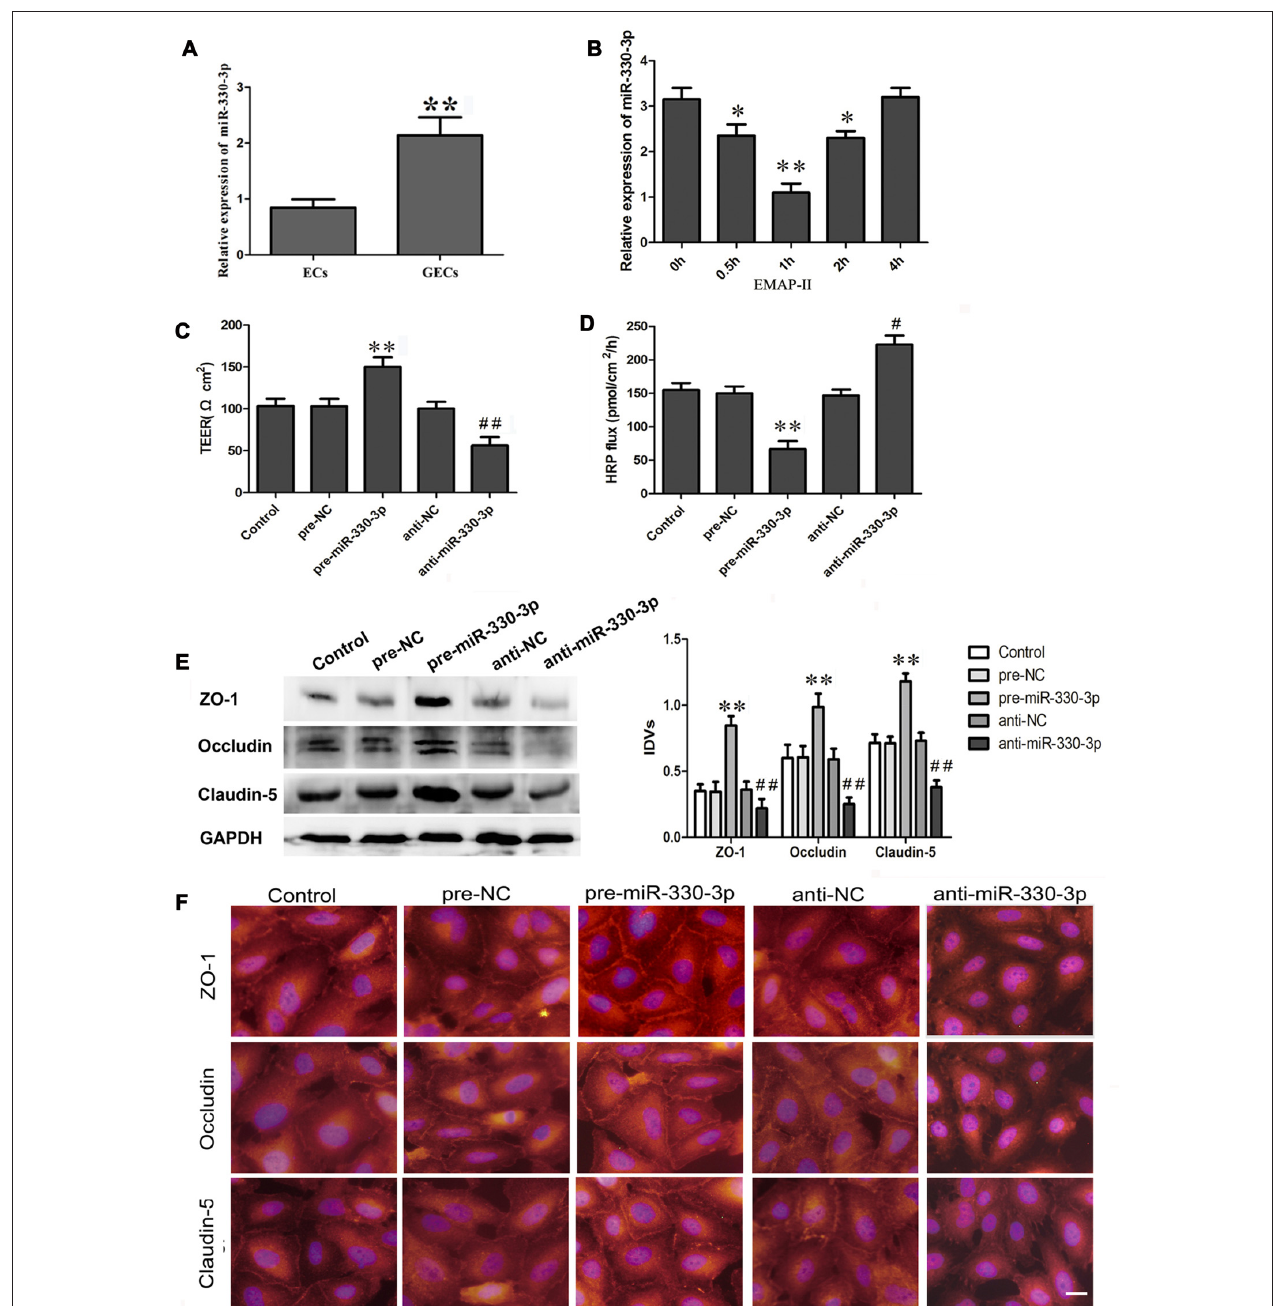
FIGURE 1 | (A) The endogenous expression of miR-330-3p in ECs and glioma microvascular endothelial cells (GECs). U6 was used as an inner control. Data represent means ± standard deviation (SD; n = 5, each). ∗∗ P < 0.01 vs. ECs group. (B) Effect of Endothelial monocyte-activating polypeptide-II (EMAP-II) on the expression of miR-330-3p in GECs. U6 was used as an inner control. Data represent means ± SD ( n = 5, each). ∗ P < 0.05 and ∗∗ P < 0.01 vs. EMAP-II 0 h group. (C,D) Transendothelial electric resistance (TEER) and horseradish peroxidase (HRP) assays were used to measure the effects of overexpression or silencing of miR-330-3p on the permeability of blood–tumor barrier (BTB). (E,F) The expression and distribution of tight junction (TJ) related proteins in GECs after overexpression or silencing of miR-330-3p. GAPDH was used as an inner control. Data represent means ± SD ( n = 5, each). ∗∗ P < 0.01 vs. pre-NC group; # P < 0.05 and ## P < 0.01 vs. anti-NC group.